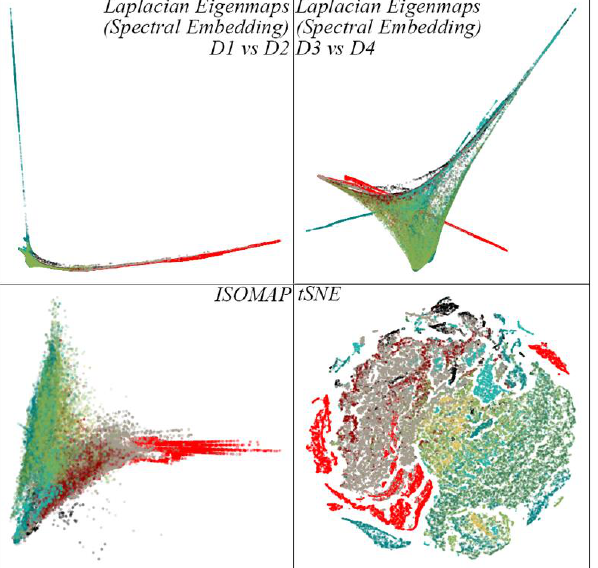
Figure A5. Comparison to other manifold learning algorithms. Results are shown for Laplacian Eigenmap-based Spectral Embedding (LE), ISOMAP, and t-distributed Stochastic Neighbor Embedding (t-SNE). LE and ISOMAP runs both use the nearest neighbor affinity metric, with n_neighbors = 10. t-SNE uses perplexity = 30 and random initialization.